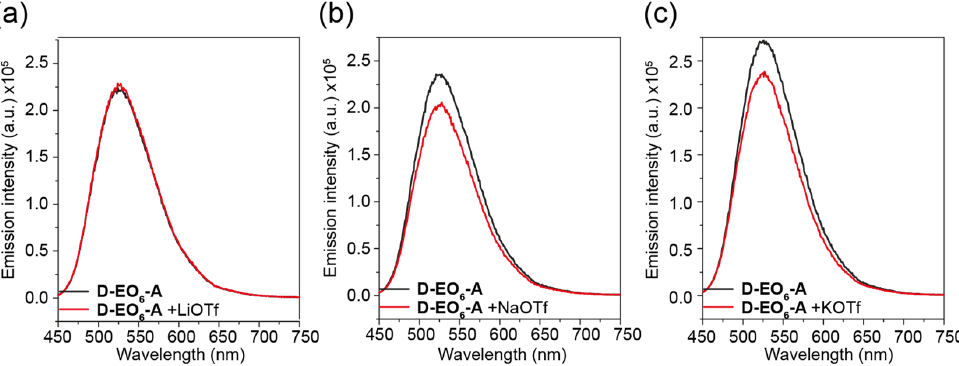
Figure 5. Emission spectra ( λ ex = 417 nm) of solutions of D-EO 6 -A ( c = 10 µmol L − 1 , in MeOH/CHCl 3 50:50 v / v %) before (black lines) and after (red lines) addition of 5 mg of the metal salts ( a ) LiOTf, ( b ) NaOTf, and ( c ) KOTf.